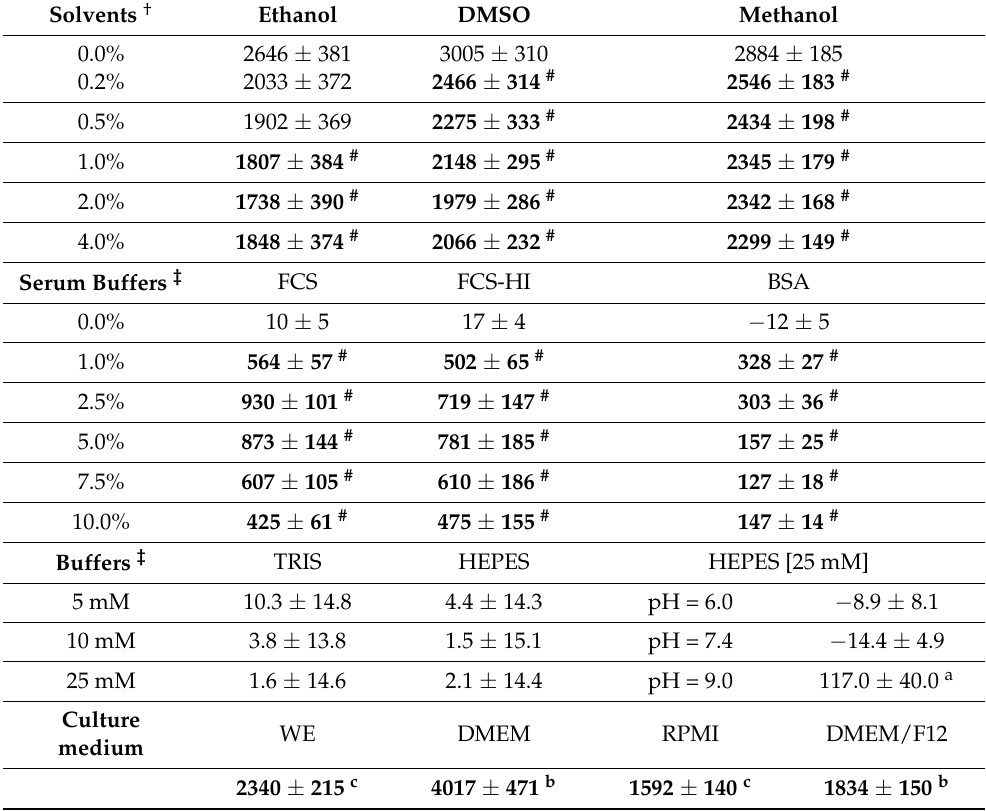
Culture WE DMEM medium 4017 ± 471 b 1592 ± 140 c 1834 ± 150